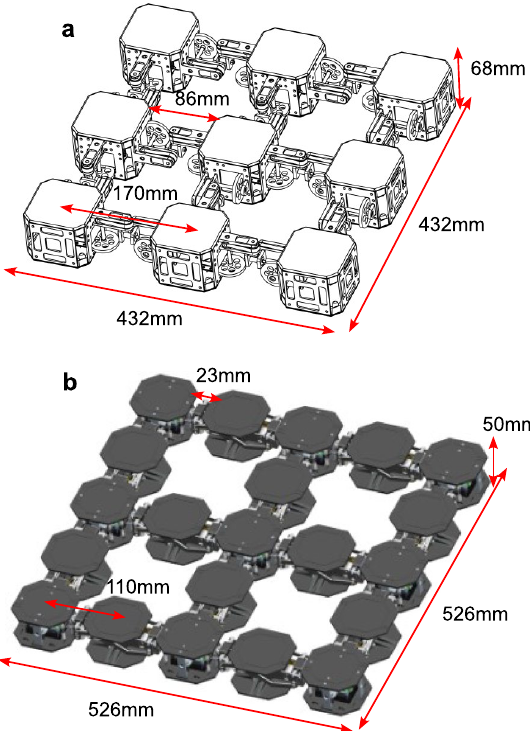
Fig. 20 Compleat design of both prototypes. a WORMESH-I. b WORMESH-II